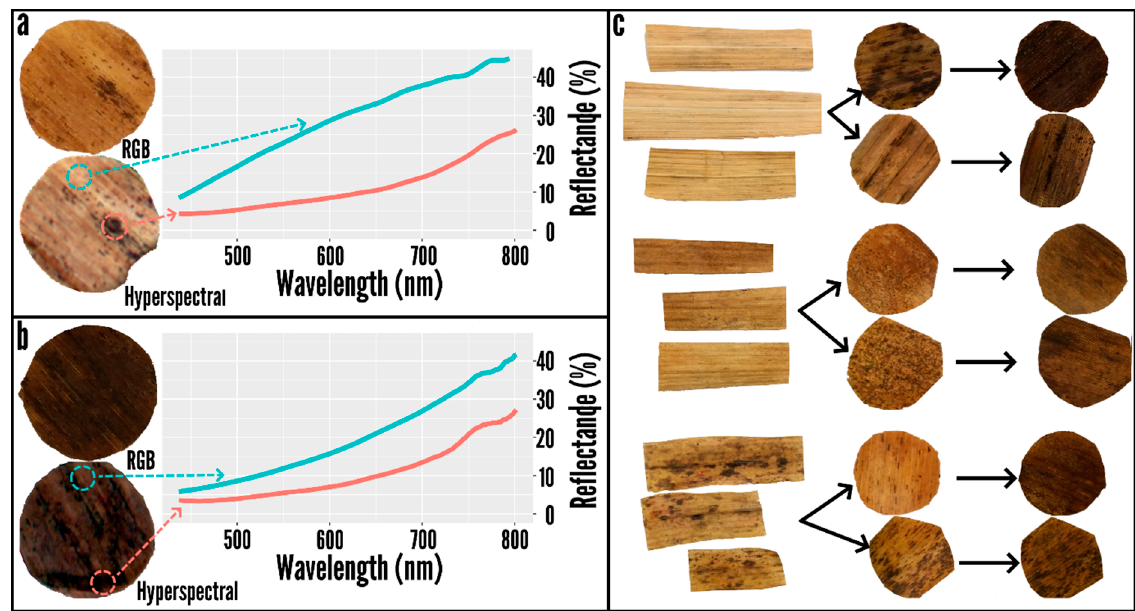
Figure 3. Progression of decay as evidenced by photographs and CRHSI of leaf discs. ( a ) Reflectance of individual pixels in CRHSI of a DMid leaf disc at Stage 1; ( b ) reflectance of the same leaf disc at Stage 3; ( c ) photographs of initial leaf groups (top to bottom: DLow, DMid, DExtreme) and progression of decomposition of the same leaf disc at Stage 2 and Stage 3.